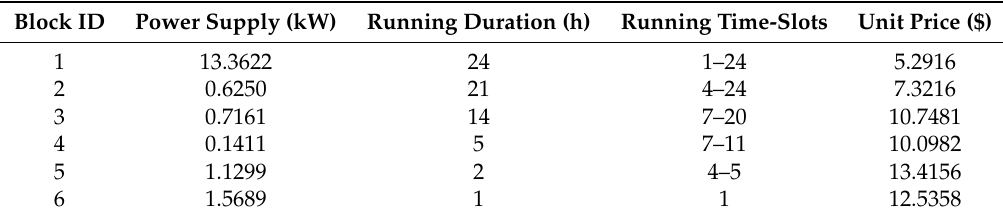
Table 4. Part of the obtained optimal strategy of Firm